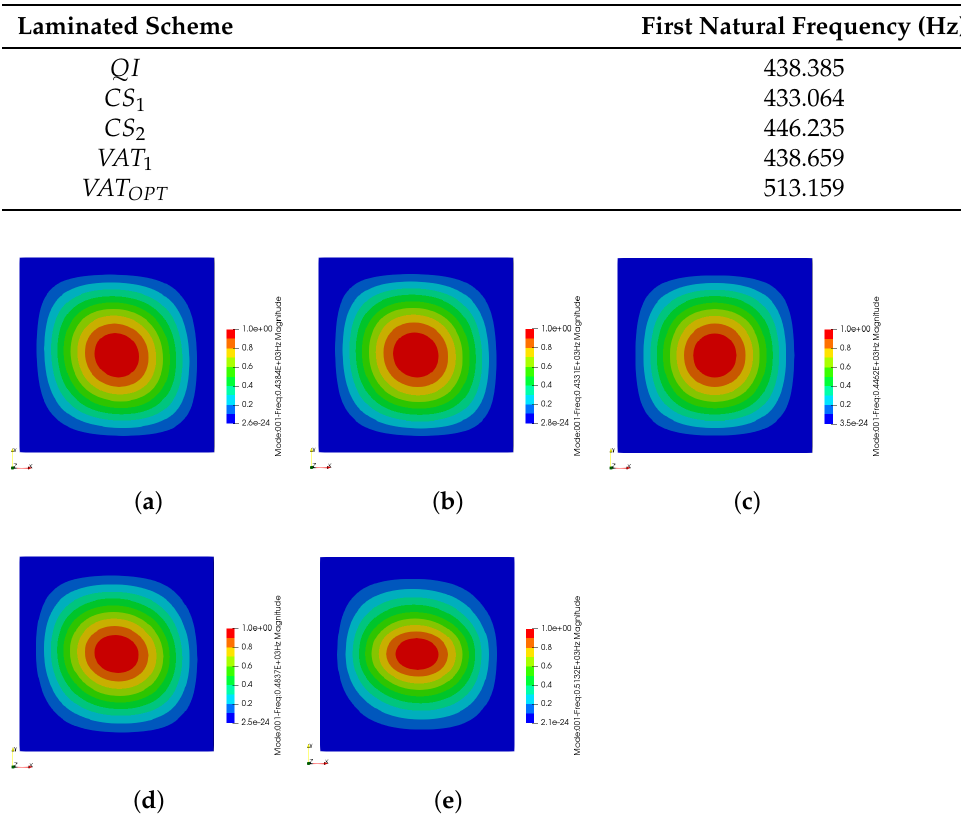
Figure 12. Contour plots and response surfaces based on GA and LHS for T 0 and T 1 as the variables and first critical buckling load as the response. ( a ) GA contour plot of variables’ sample points ( F cr is represented by the colors). ( b ) LHS contour plot of variables’ sample points ( F cr is represented by the colors). Table 4. Frequency results for reference laminate lay-up designs in contrast to optimum VAT plate.